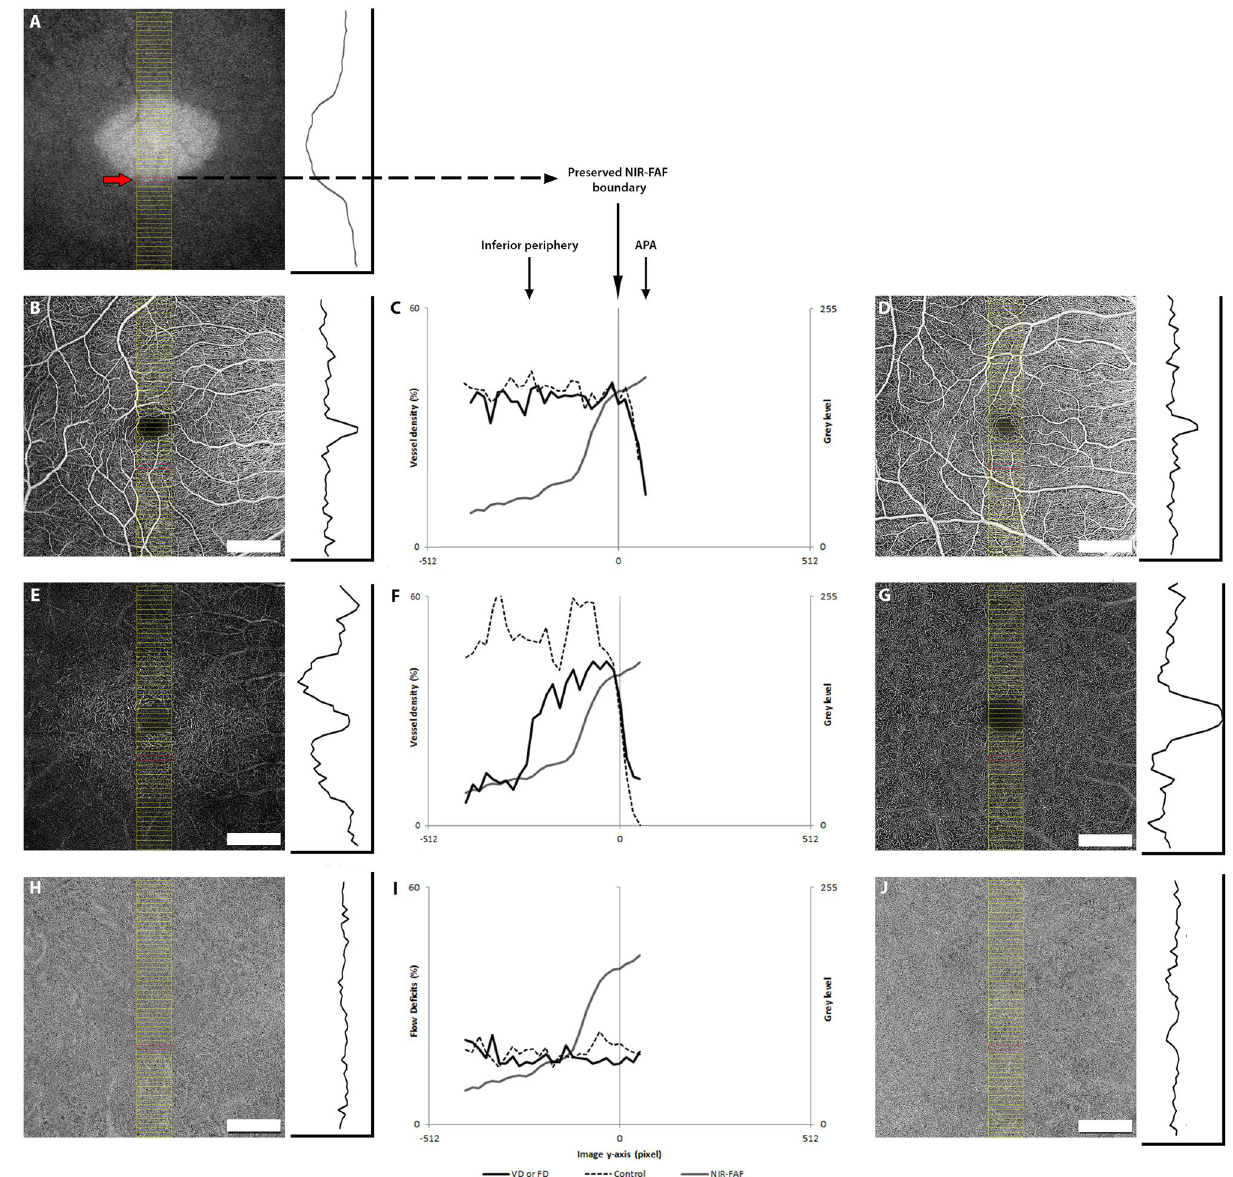
sample areas passing through the fovea (yellow rectangles in A , B , D , E , G , H and J ) and spanning in three directions: superior, inferior and temporal (the latter not shown). The NIR-FAF image of the affected subject ( A ) was used to evaluate the intensity level (IL) profile, while the angiograms were used to quantify the vessel density (VD) of the superficial vascular plexus (SVC, B ), the deep capillary complex (DCC, D ) and the flow deficits (FD) of the choriocapillaris (CC, F ). For each direction (superior, inferior and temporal), a graph was built where the IL (from A ) was superimposed with the VD ( C , F ) or the FD ( I ) of the affected subject and of an age-matched control (black dotted lines in D , G and J ). The preserved NIR-FAF (APA) boundary (which corresponded to the sharp decline of the IL in NIR-FAF, red arrow in A and red rectangles in A , B , D , E , G , H and J ) was taken as “0” in the x-axis in order to allow the averaging of the data from the entire